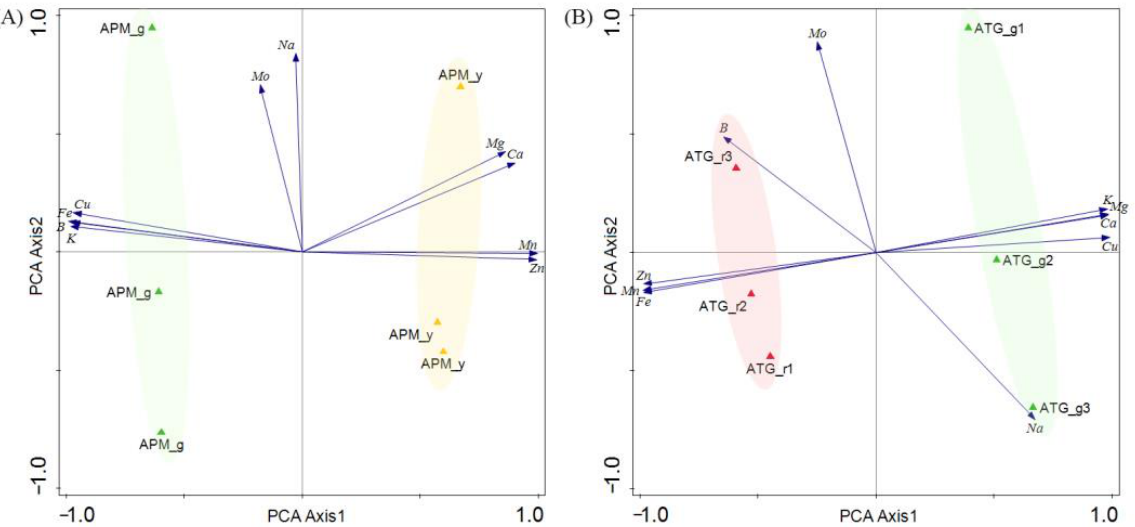
Figure 3. PCA analysis of mineral elements in APM and ATG leaves in different seasons: ( A ) APM and ( B ) ATG. APM_g: APM with green leaves; APM_y: APM with yellow leaves; ATG_g: ATG with green leaves; ATG_r: ATG with red leaves.